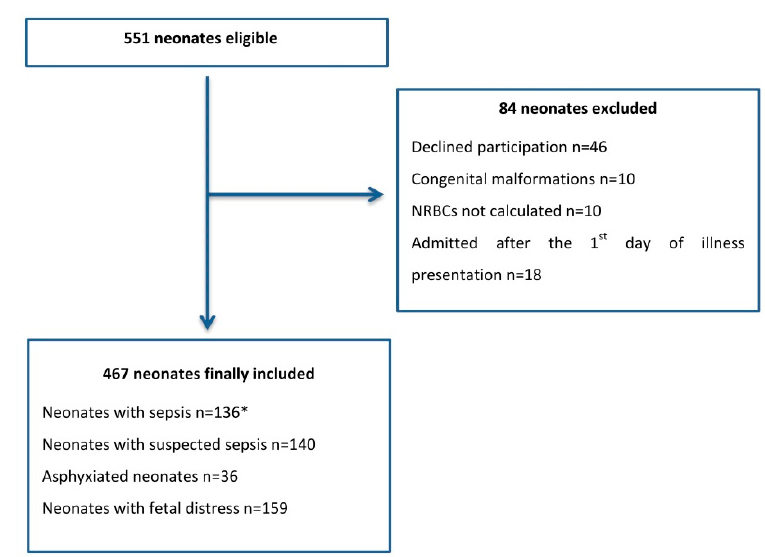
Figure 1. Flowchart of study population. * 4 neonates with perinatal hypoxia were also included in this subgroup, as they suffered from late-onset sepsis. Abbreviation: NRBCs, nucleated red blood cell counts.